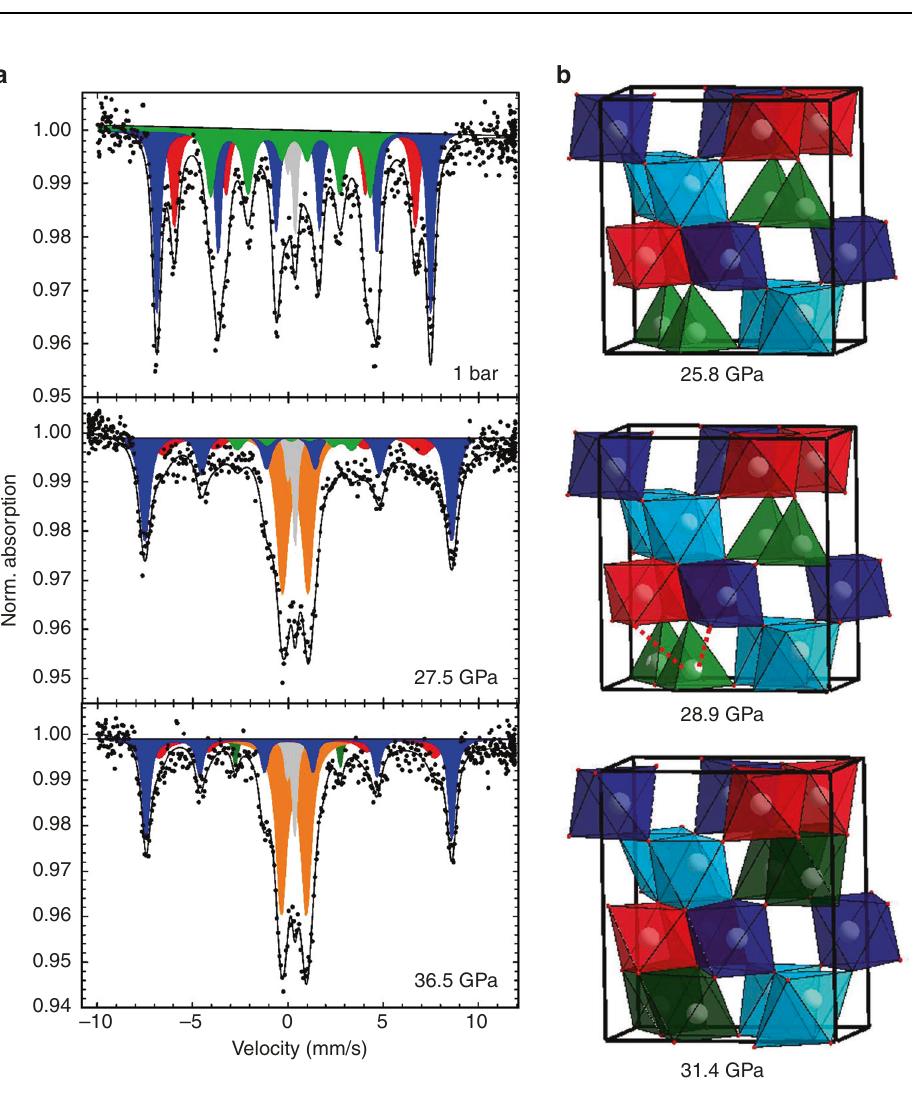
Fig. 5 Synchrotron-based Mössbauer spectroscopy of ε -Fe 2 O 3 collected before, during and after the volume collapse. a Mössbauer spectra of the ε -Fe 2 O 3 below (1 bar), during (27.5 GPa) and above (36.5 GPa) the critical pressure. Blue sextet: Fe(1,2) irregular octahedral sites; red sextet: Fe(3) regular octahedral site; green sextet: Fe tet (4) regular tetrahedral site; dark green sextet: Fe oct (4) regular octahedral site after transition from tetrahedral geometry; orange doublet: paramagnetic high-spin Fe 3 + state, caused by the progressive loss of hyper fi ne fi eld in all iron sites upon compression; gray doublet: contribution from iron in Be-lenses. b Structural layout below, during and above the critical pressure